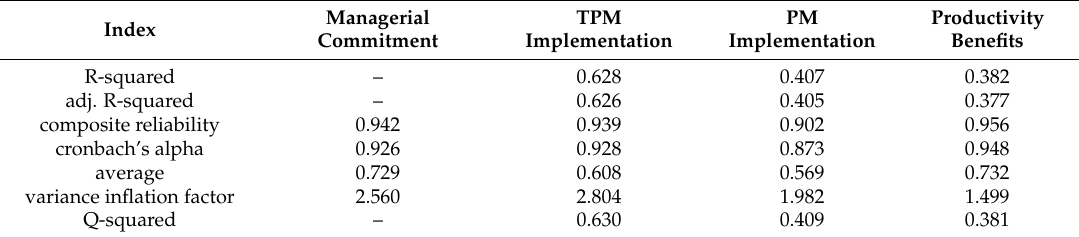
Table 4. Survey validation.